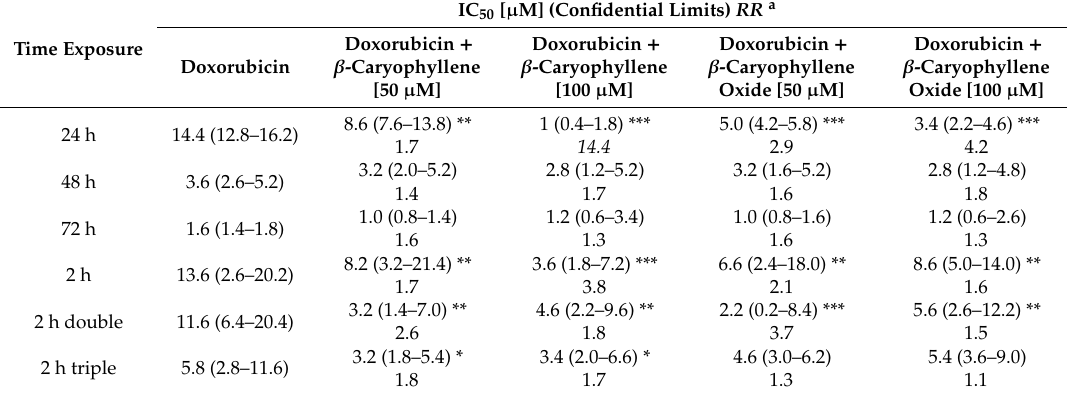
Table 2. IC 50 values of doxorubicin and its combination with β -caryophyllene or β -caryophyllene oxide under the scheduled exposure protocols. Data represent the mean ± SE (standard error) of at least two experiments in which each treatment was tested in triplicate ( n =